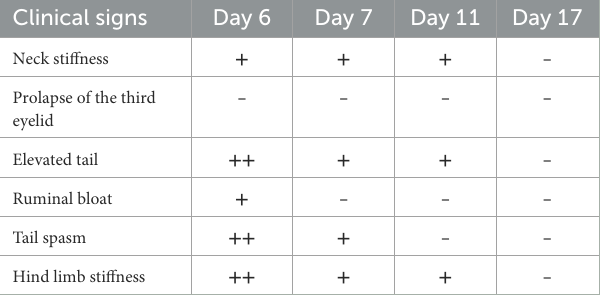
FIGURE5 Relieved tail elevation and normal feed intake after tetanus treatment. Due to the treatment of tetanus (17 th day of occurrence), recovery of both the stiff hind limb and tail elevation was observed, and the patient began to freely eat food from the floor.